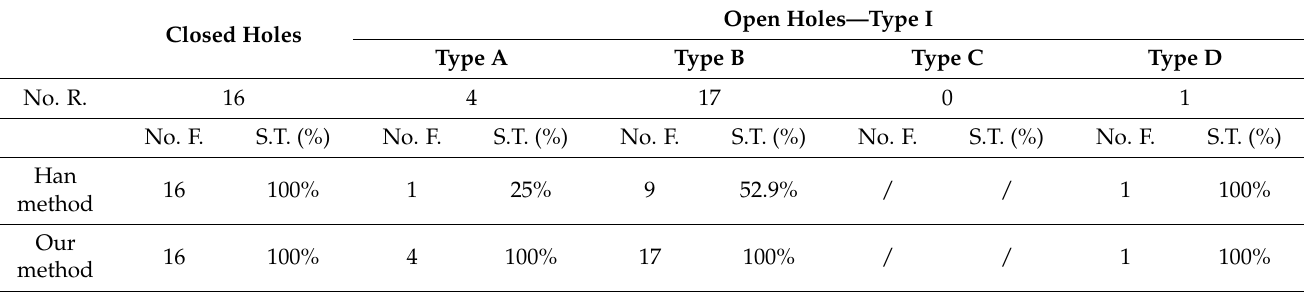
Table 1. Distribution and repair statistics of closed holes and type I open holes.